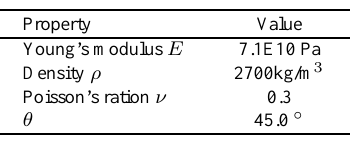
Table 1 Properties of Cantilevered Curved Beam